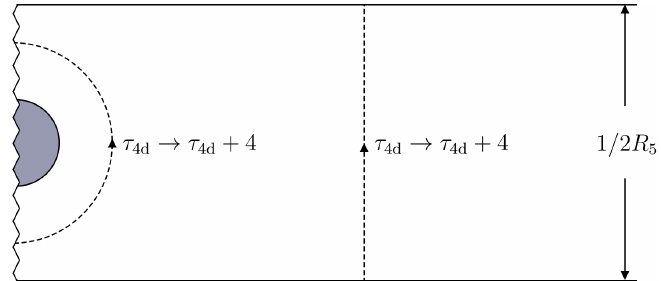
Figure 8 . Schematics of the F0 moduli space in terms of φ + iA 5 ; the top and the bottom boundaries should be identified while the left end should be folded in half. The shaded region represent 4d Seiberg-Witten geometry of the pure Sp(1) theory.